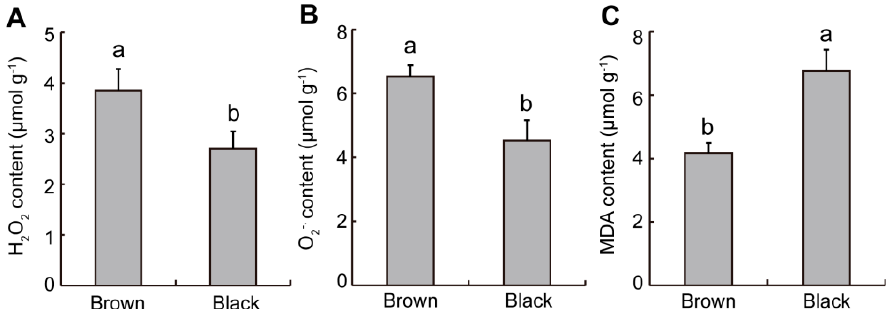
Figure 2. Determination of ROS levels in dimorphic seeds of S. liaotungensis . ( A ) H 2 O 2 content. ( B ) O 2 − . content. ( C ) MDA content. Different letters show significant differences ( t - test, p < 0.05).